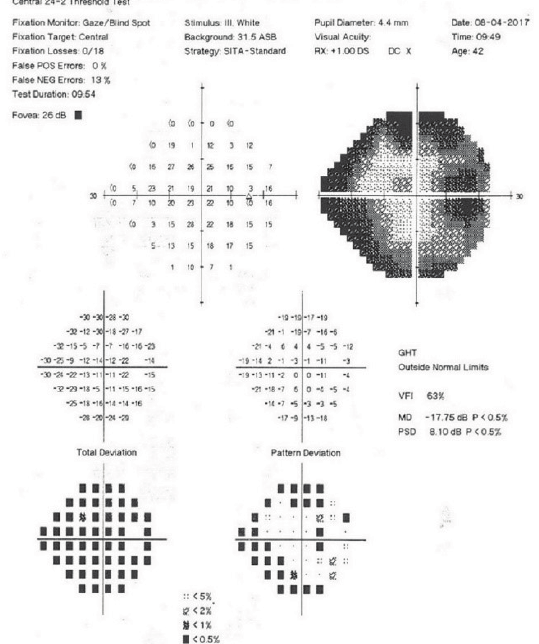
Figure 2. Humphrey’s visual field test of the right eye (SITA standard 24-2) shows double arcuate scotoma with enlargement of the blind spot and severe generalized